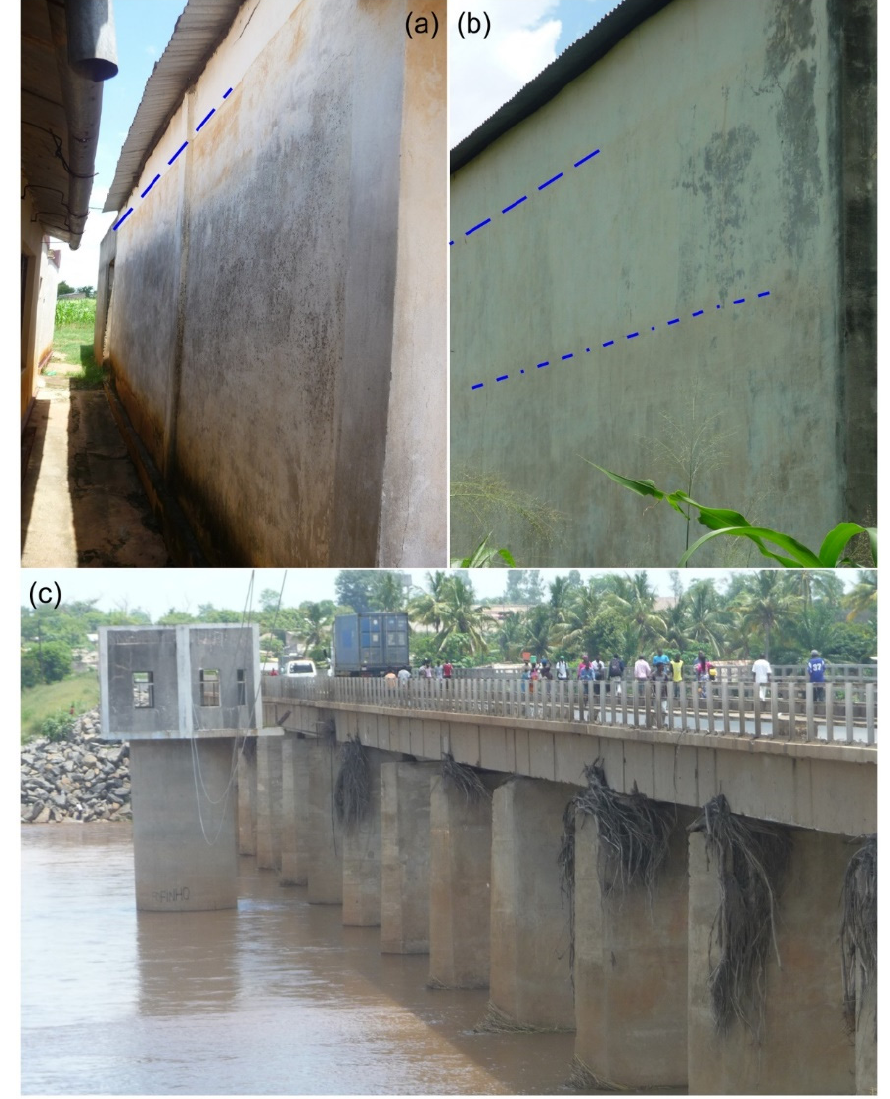
Figure 2. Field data evidence of January 2015 flooding event: palaeostage indicators for CP-01 ( a ) and CP-05 ( b ), where blue dashed lines show the water level (flood marks) at these points; Mocuba gauge station and bridge with palaeostage indicators (driftwood) ( c ).